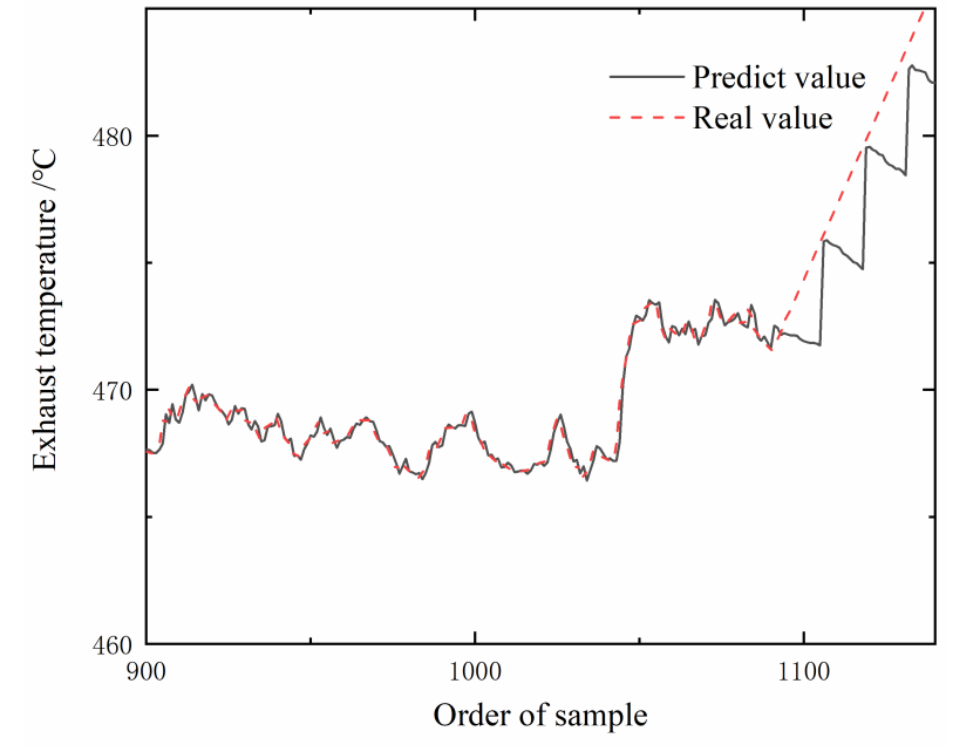
Figure 14. Abnormal condition exhaust temperature prediction.